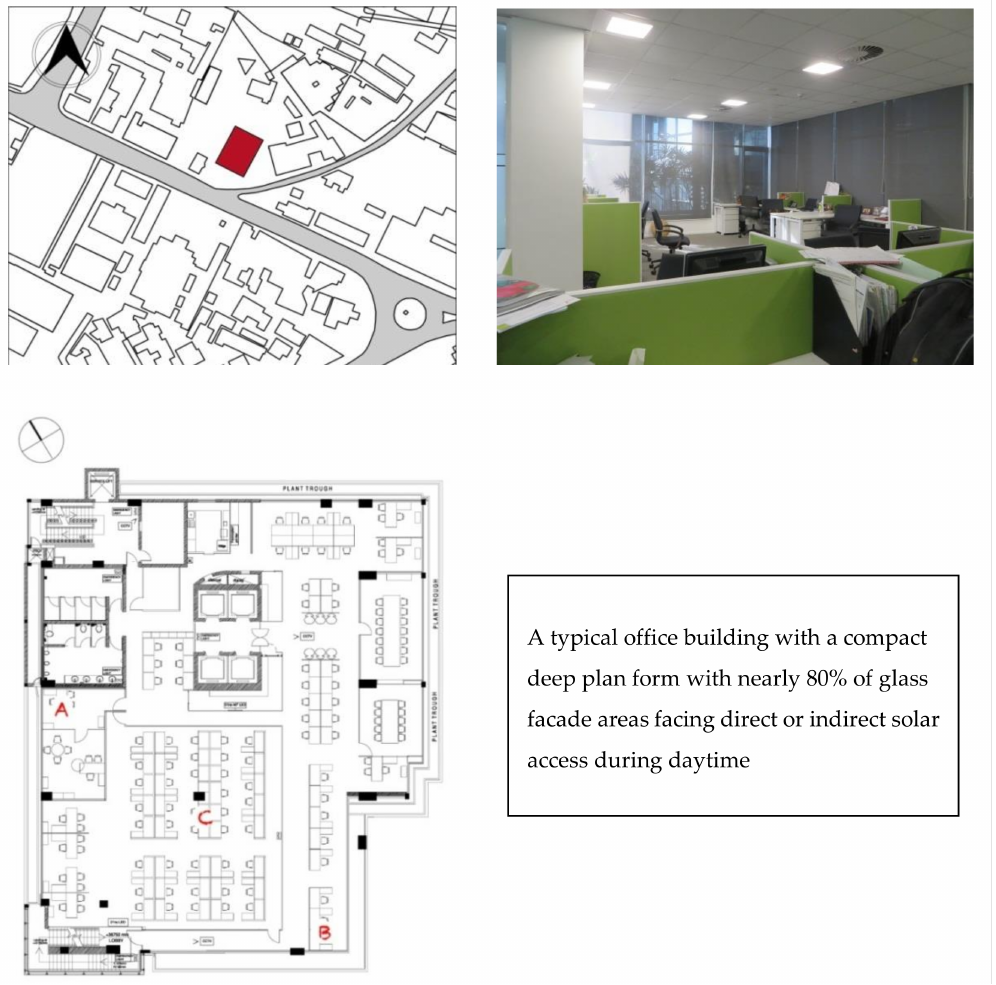
Figure 6. Deep square plan form of the Building B (plan depth—24 m, length—55 m) Top left—Layout in the urban setting, Images—internal o ffi ce and equipment setting, Bottom—typical floor